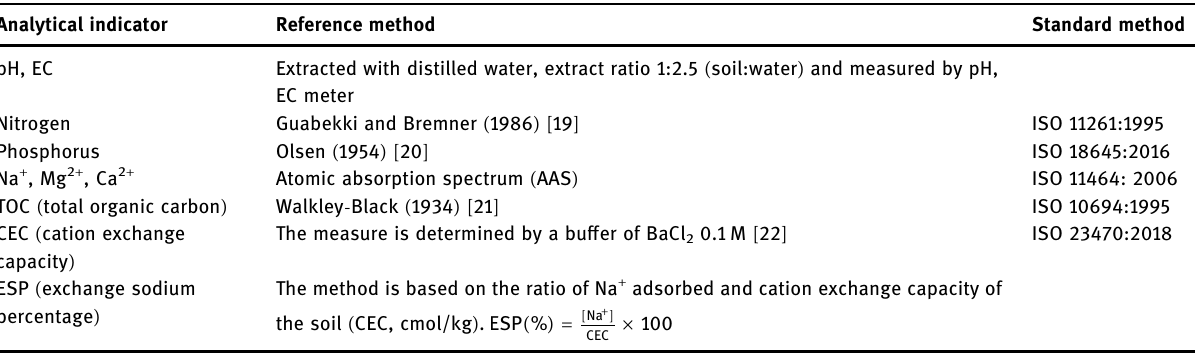
Table 1: Methods of analyzing soil parameters Analytical indicator Reference method Standard